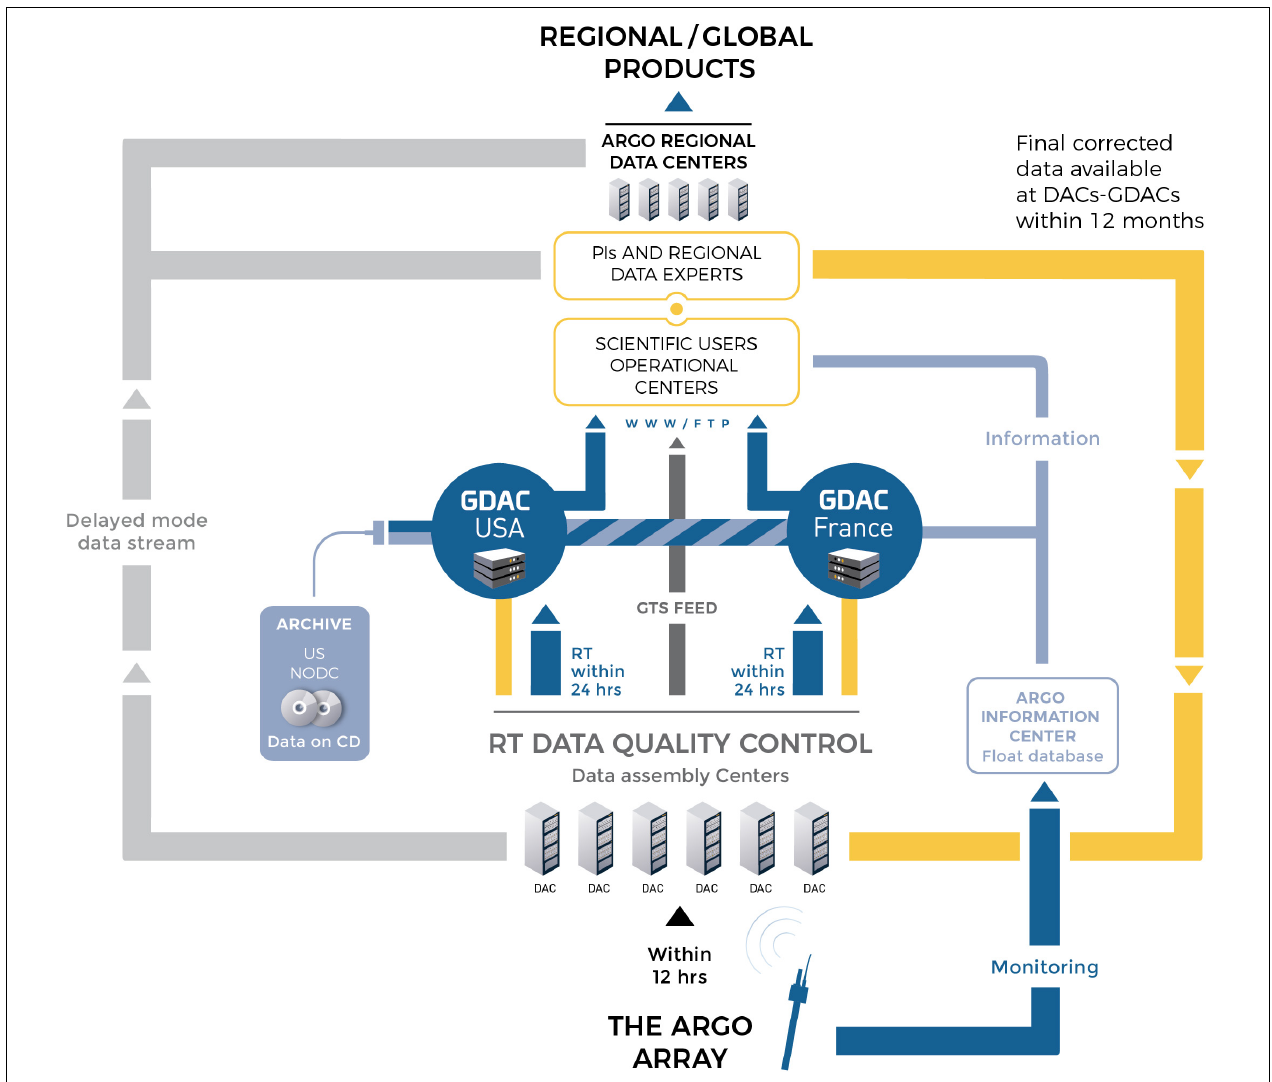
FIGURE 2 | Pathways of Argo near-real time and delayed-mode data and meta data are illustrated, originating from the Argo array and being distributed to users via the GDACs. (Copyright: Euro-Argo ERIC, printed with